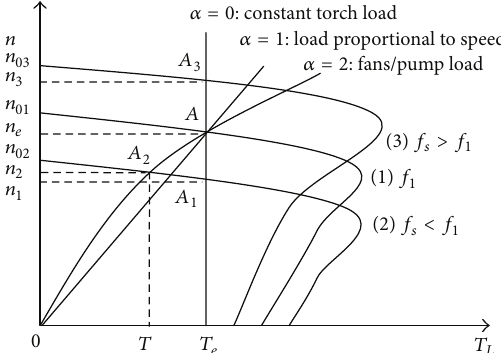
Figure 3: Torque-speed characteristic curve of squirrel-cage motor with different load